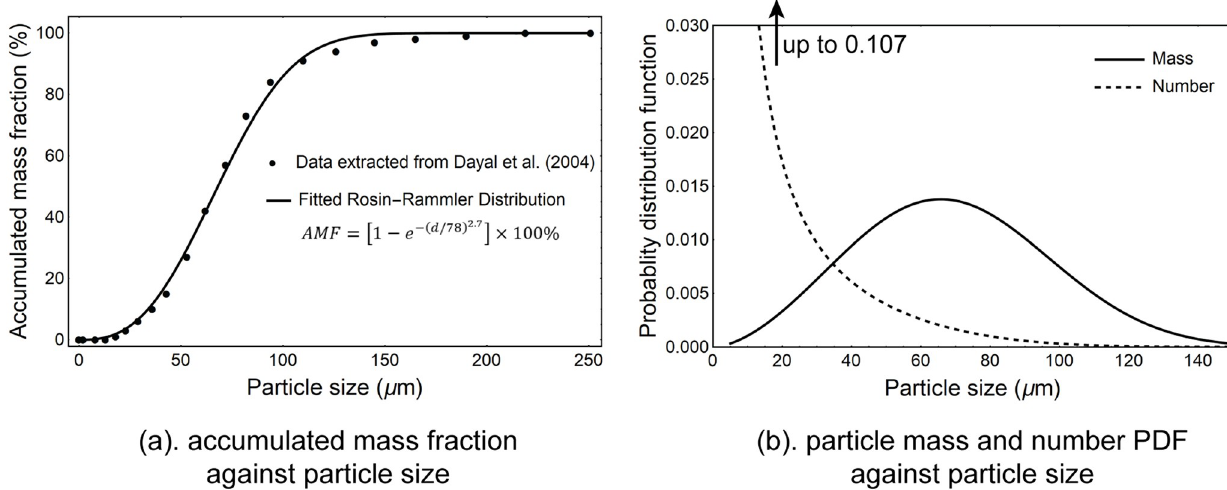
Fig 3. Spray drug particle size distribution used in the CFD simulation. (a) Measured data from Dayal et al. [30] showing cumulative mass fraction, fitted using Rosin-Rammler Distribution. (b). The corresponding mass and number probability distribution function over particle size. The range of particle size released was 1 − 150 μm